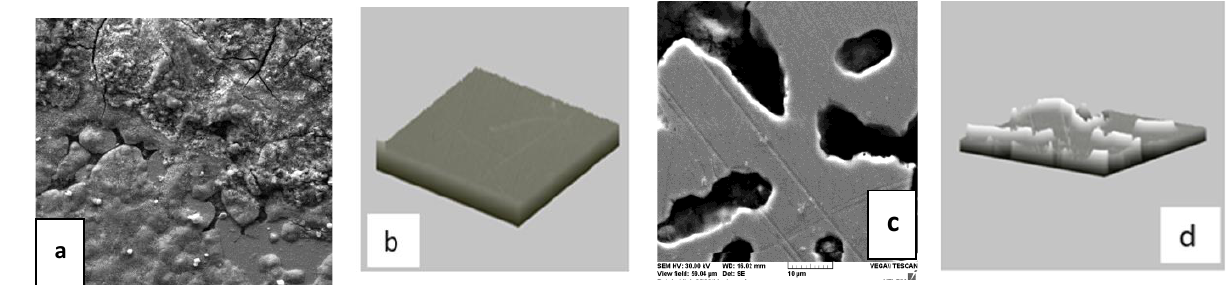
Figure 8. Microstructure of the Cr-Ni alloy surface before corrosion (( a )—cracks on the surface of the sample; ( b )—the surface of the sample is uneven with small roughnesses of small sizes) and after corrosion (( c )—corrosion process develops over the entire surface; ( d )—roughnesses of variables distributed over the entire surface of the sample).